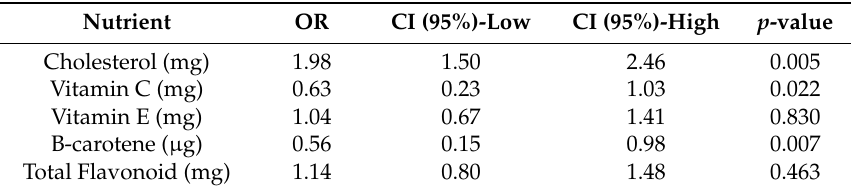
Table 5. Multiple logistic regression derived ORs and 95% CI with associated p -values per one standard deviation increment of the major categories of micronutrients for all ocular conditions